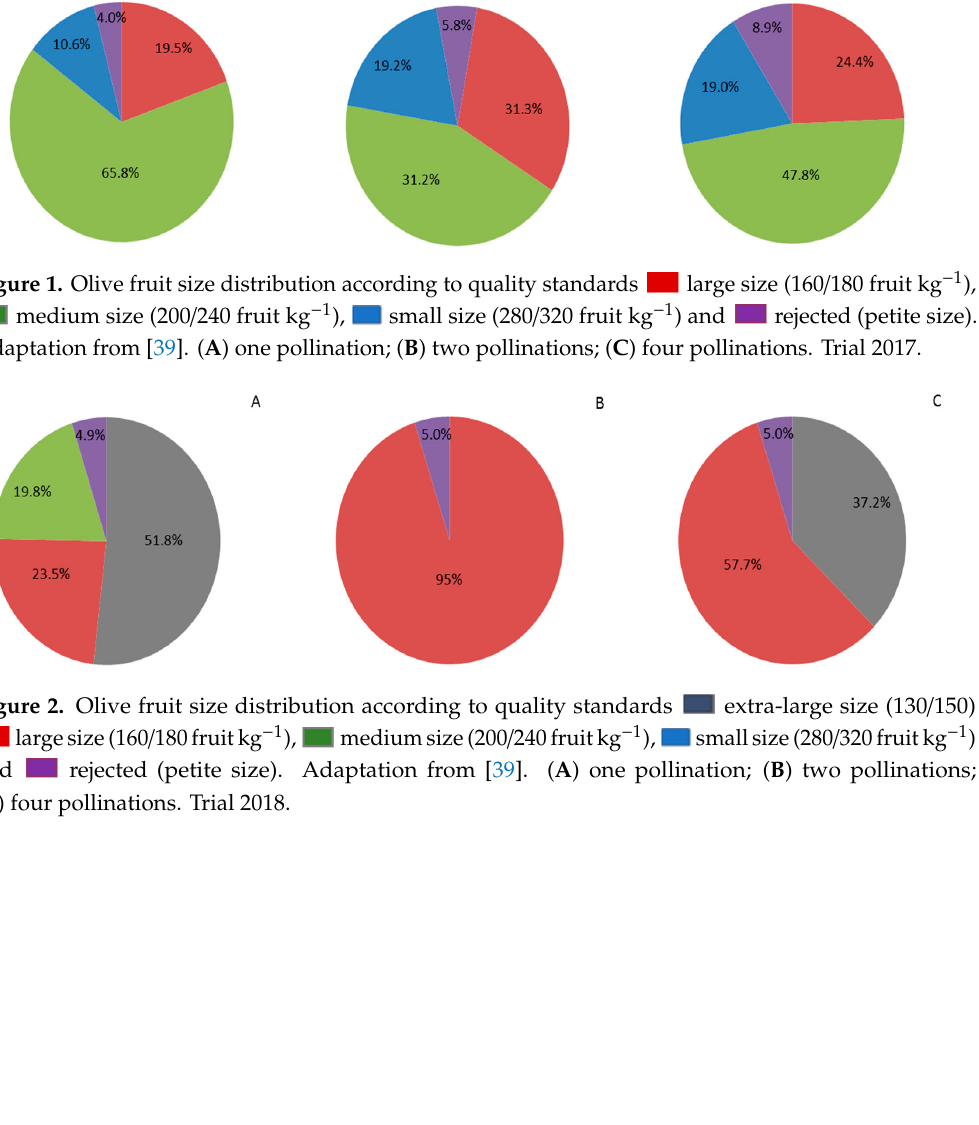
Table 1. Fruit set, size and estimated yield in monovarietal ‘Manzanillo’ olive orchards with different frequencies of artificial pollination (2017 and 2018).